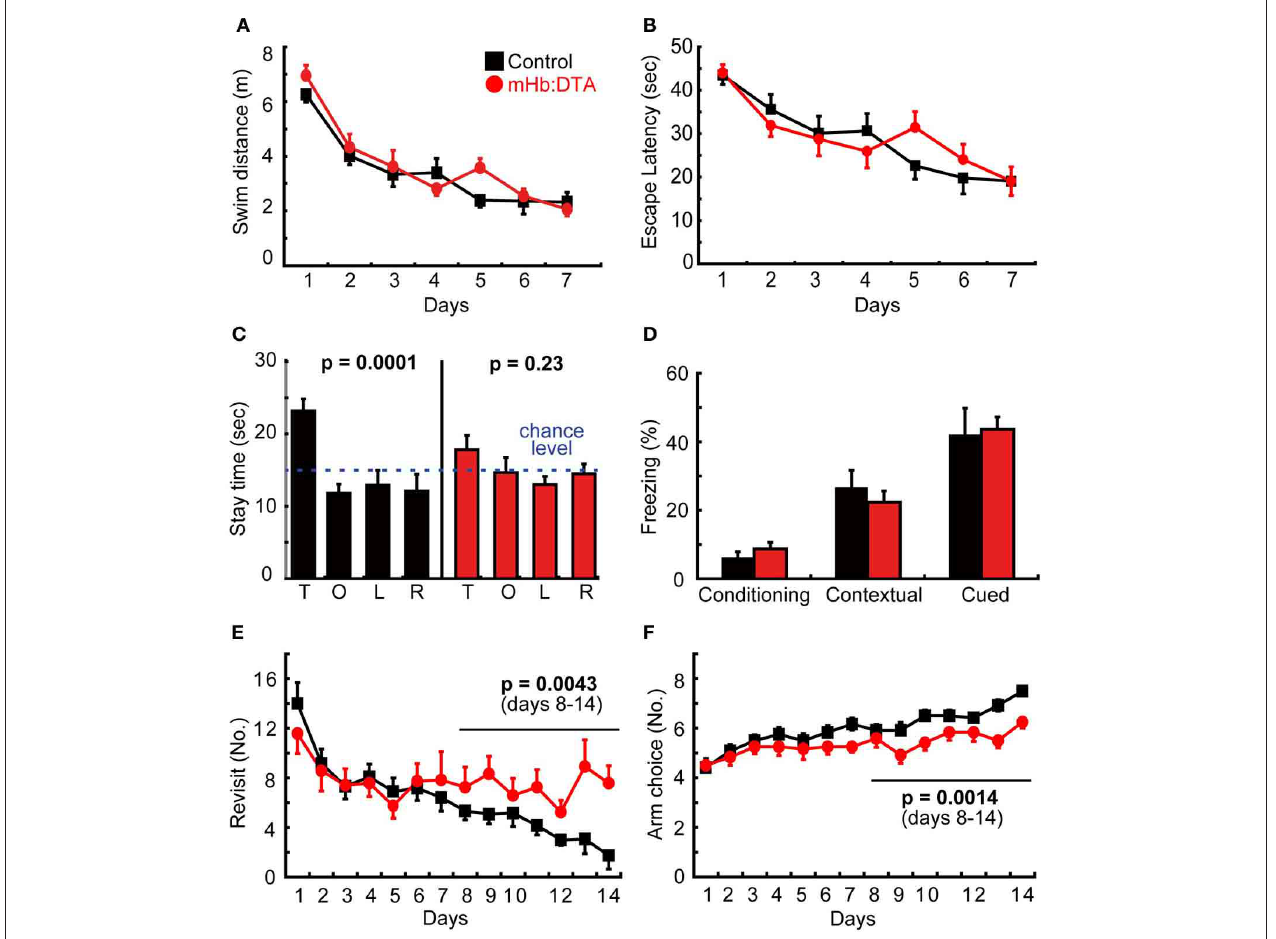
FIGURE 5 | Learning and memory in mHb:DTA mice. (A–C) Spatial learning and memory in the Morris water maze (mice were 7–8 months-old, n = 12/group). (A) There were no differences between genotypes in the acquisition rates, swim distances (A) , or escape latency (B) . (C) Probe tests revealed significant quadrant preference for the controls [ F ( 3 , 44 ) = 8 . 5] but not mHb:DTA mice [ F ( 3 , 44 ) = 1 . 5]. T, O, L, and R represent target, opposite, left and right quadrants,